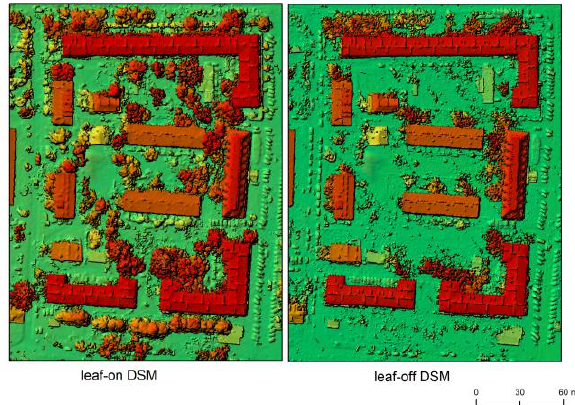
Figure 4. Comparison of leaf-on and leaf-off DSM